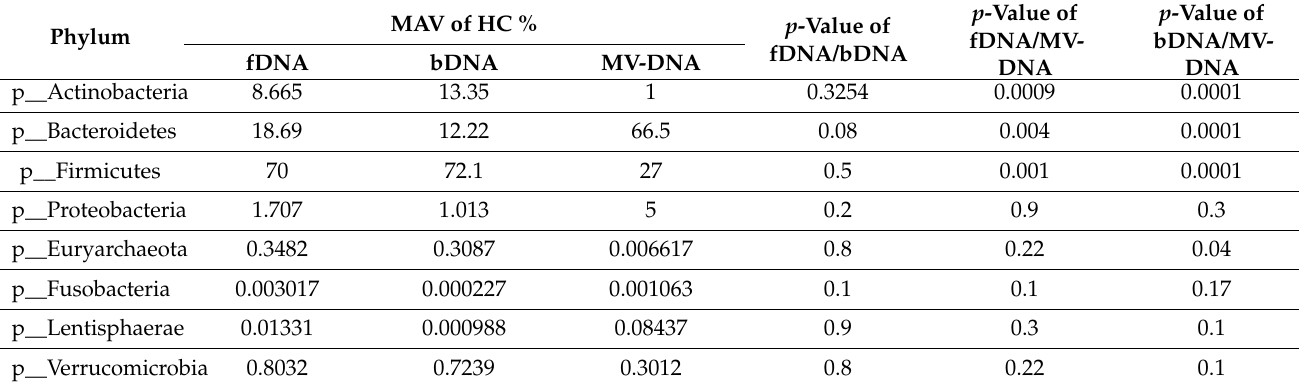
Figure 2. Comparison of relative abundances of the most dominant phyla between the three DNA conditions. The graphs represent the relative differences in healthy controls. (fDNA) DNA obtained directly from fecal samples, (bDNA) DNA obtained from pellet of dissolved feces in PBS–bacteria DNA, and (MV-DNA) DNA obtained from MV fractions. Table 1. Significantly different phyla in MV microbiome compared to fDNA and bDNA compositions in HC. MAV (mean abundance value). A Mann–Whitney test was used to determine the p -value.